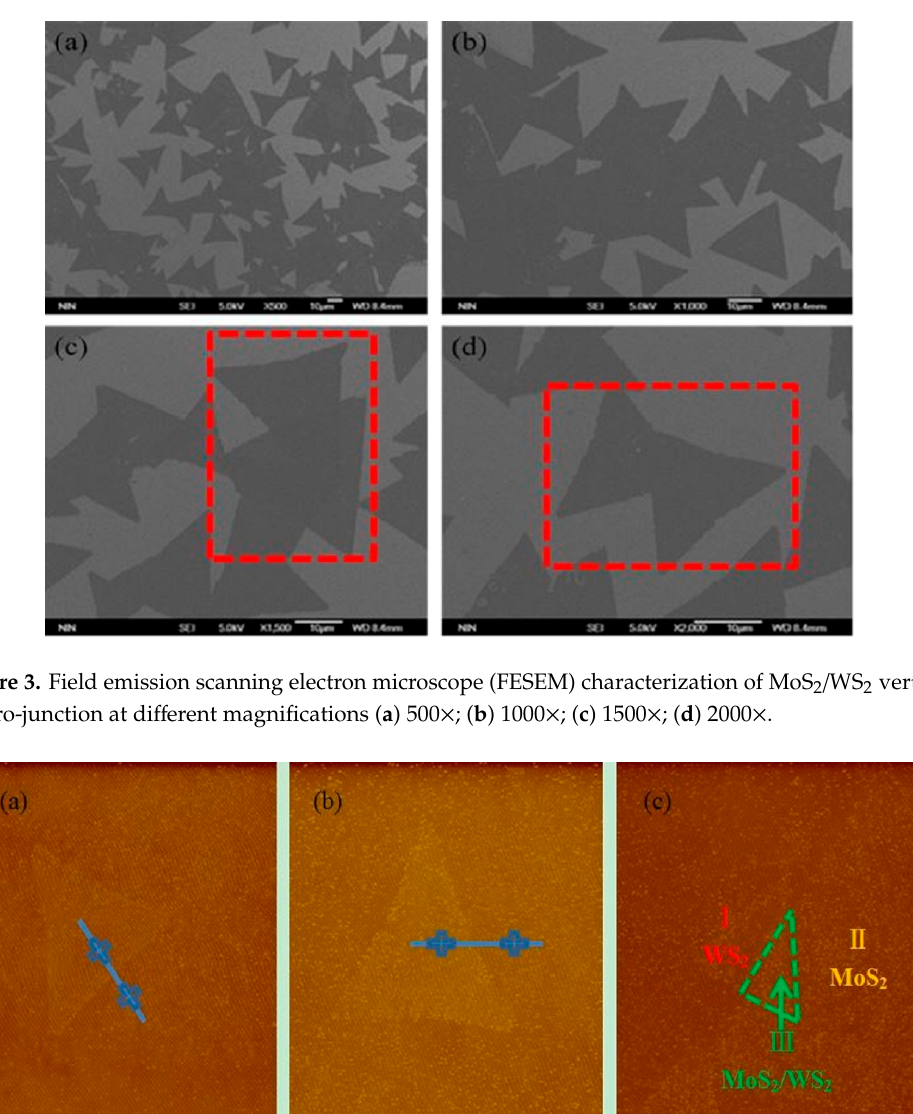
Figure 2. Optical microscopy images of MoS 2 /WS 2 vertical hetero-junction at different magnifications